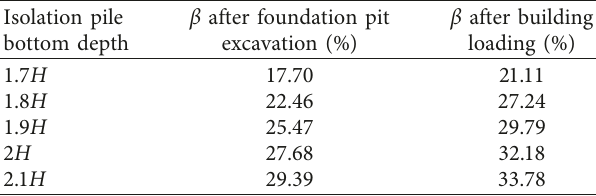
Figure 30: Decrement in maximum horizontal displacement of the tunnel structure under different isolation pile bottom depths. Table 10: Reinforcement effects of isolation piles on torsional deformation of the tunnel structure under different isolation pile bottom depths.